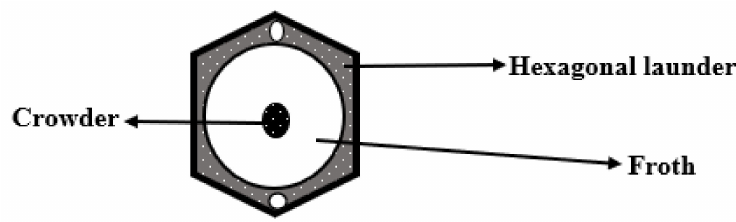
Figure 6. Hexagonal launder